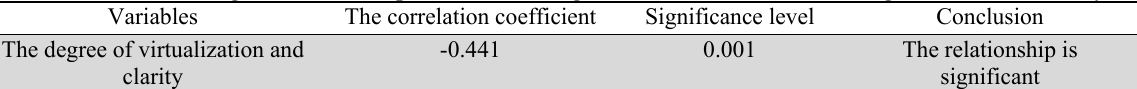
The results of the testing the relationship between the degree of virtualization of the organization and clarity Variables The correlation coefficient Significance level Conclusion The degree of virtualization and clarity